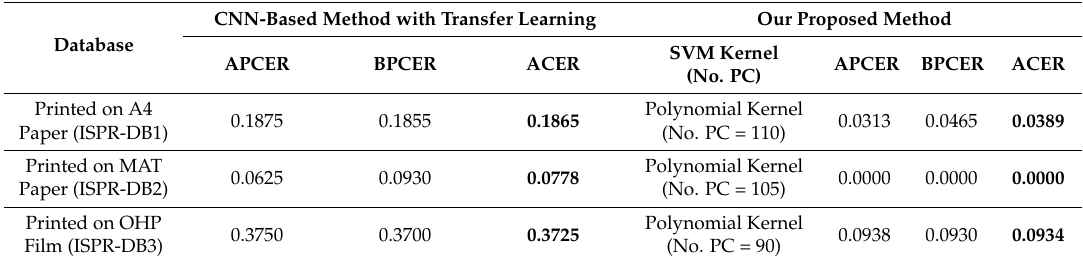
Table 14. Detection errors of our proposed method using Alex network architecture in Table 2 on sub-databases of ISPR-DB based on the printing materials (unit: %).